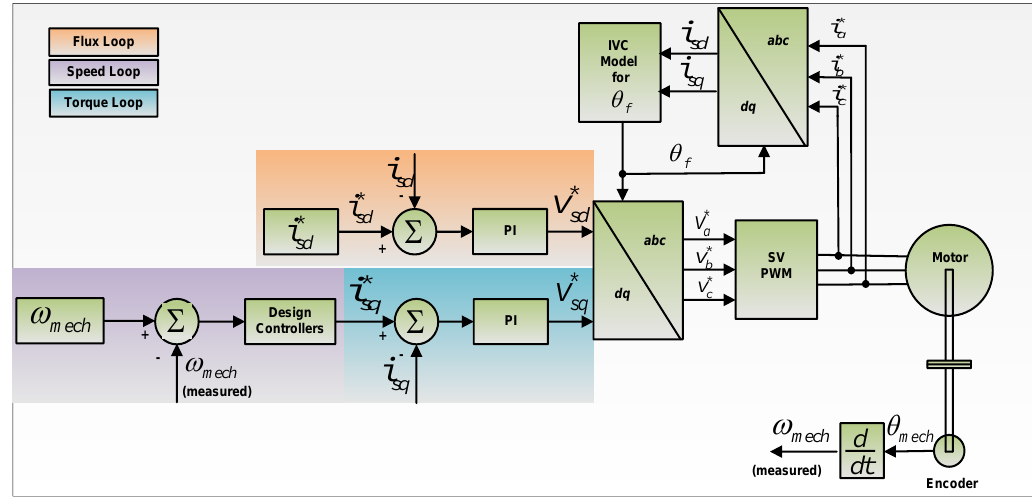
calculation. calculation. 𝜃𝜃 𝑓𝑓 𝜃𝜃 𝑓𝑓